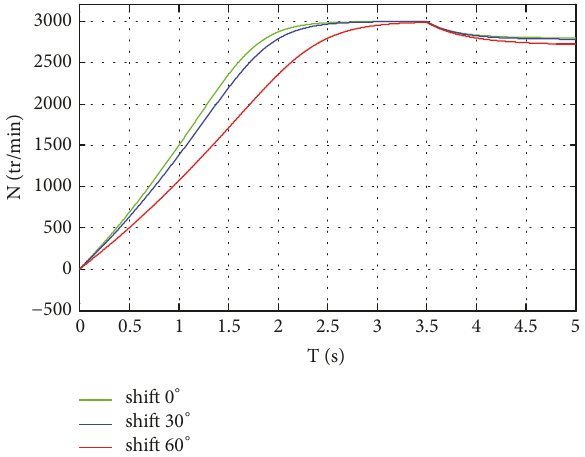
Figure 12: Characteristic of rotational speed.